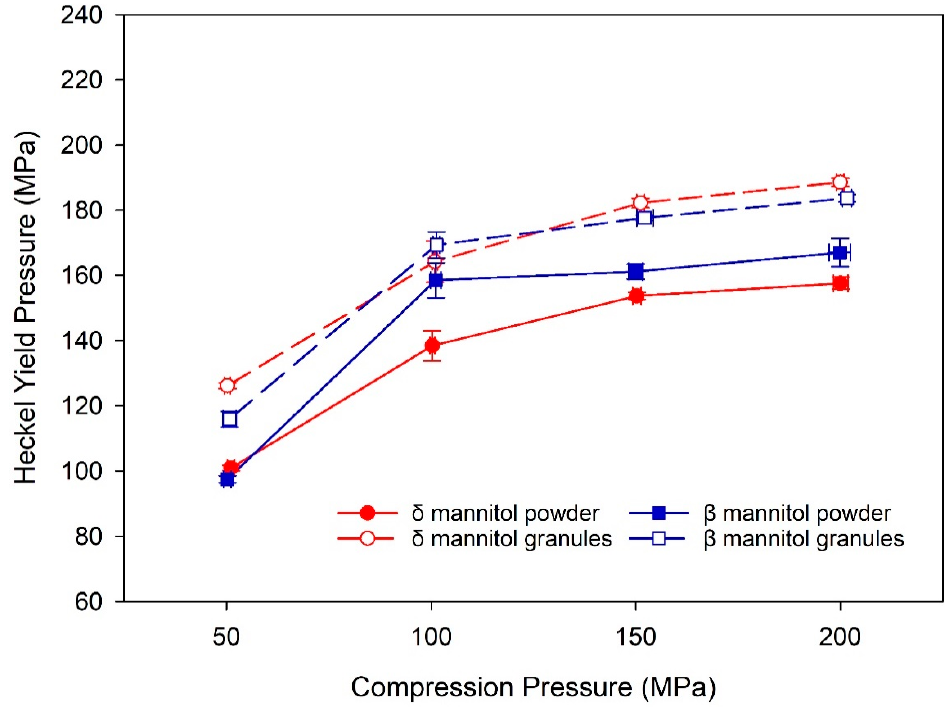
Figure 4. Heckel Yield pressure of δ and β mannitol powder and their respective granules. Arithmetic means of n = 10 ± S.D.